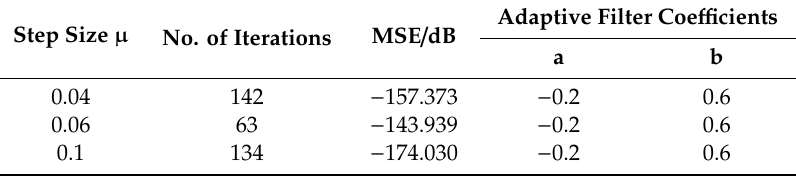
Table 3. Simulation of adaptive IIR filter (white signal).